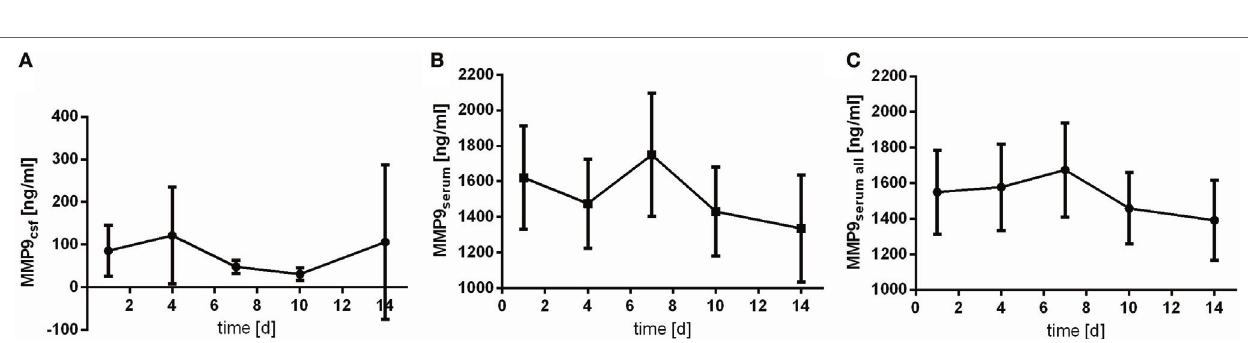
FigUre 1 | Time courses of interleukin 6 (IL6) in cerebrospinal fluid (CSF) samples [ (a) ; IL6csf], serum samples of the patients with CSF samples [ (B) ; IL6serum], and all serum samples available [ (c) ; IL6serum all] and their 95% confidence interval are displayed. Differences between nadir and peak values assessed via Wilcoxon Rank Test: IL6serum: day 14 vs. day 1: p = 0.029; IL6csf: day 1 vs. day 4: p = 0.184.